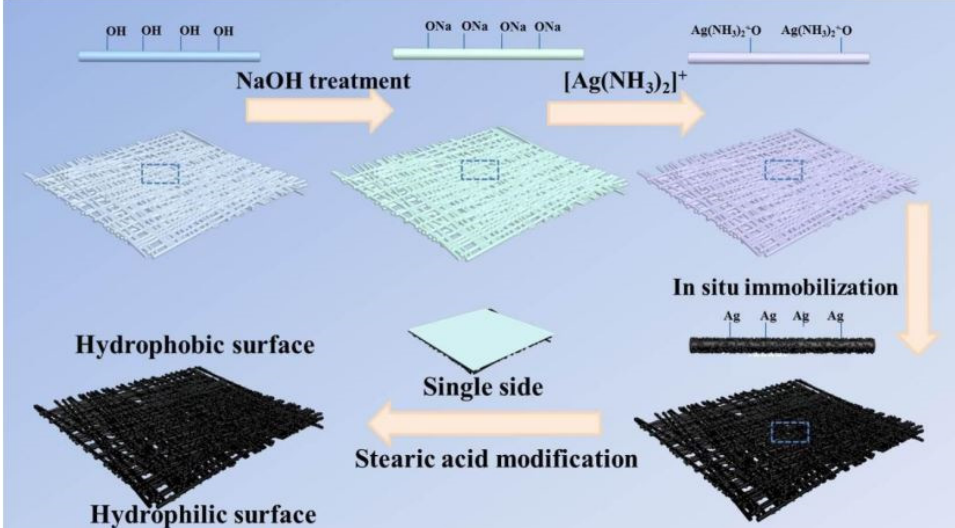
Figure 11. Janus cellulose membrane preparation by a facile method to enable switchable emulsion separation at the surface. Reprinted from [180]. Copyright 2019, with permission of ACS.